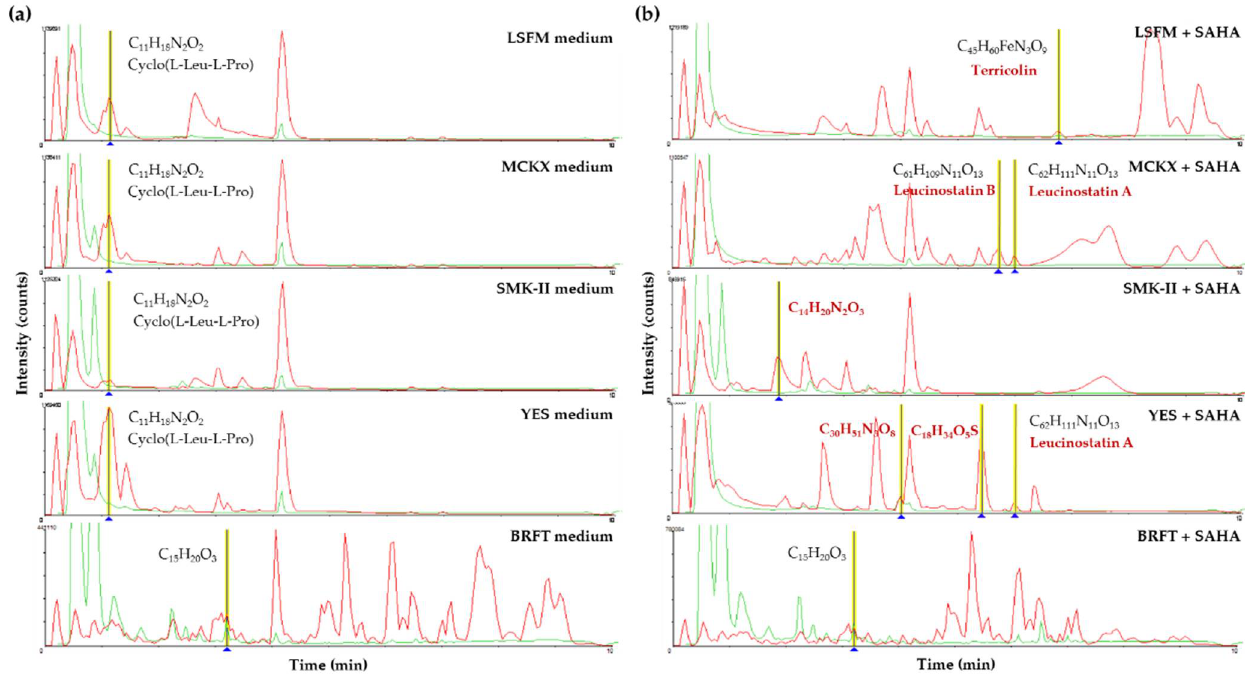
Figure 11. Comparative analysis of HR-MS profiles produced by fermentation of the strain Corticium sp. CF-166036 in five different media ( a ) without SAHA addition and ( b ) supplemented with SAHA. HPLC/UV at 210 nm profiles in green and HPLC/HR-MS profiles in red.